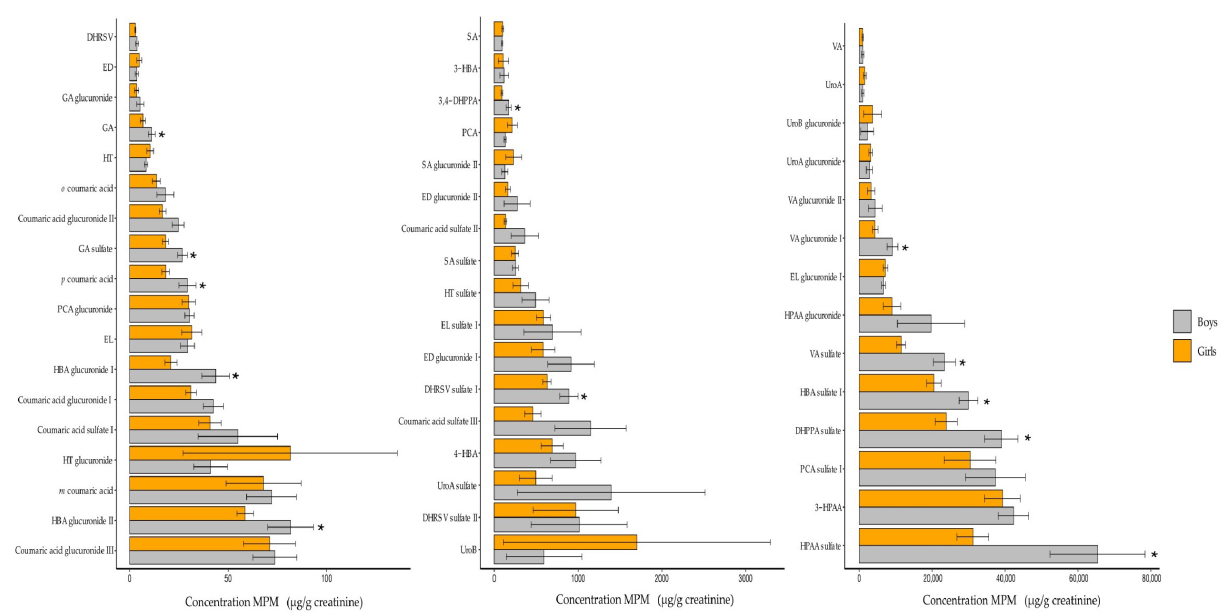
Figure 1. Urinary MPM of adolescents by gender. 3,4-DHPPA 3,4-dihydroxyphenylpropionic acid, 3-HPAA 3-hydroxyphenylacetic acid, 3-HBA 3-hydroxybenzoic acid, 3-HT 3-hydroxytyrosol, 3-HT-G 3-hydroxytyrosol glucuronide, 4-HBA 4-hydroxybenzoic acid, DHRSV dihydroresveratrol, ED en- terodiol, EL enterolactone, GA gallic acid, PCA protocatechuic acid, SA syringic acid, Uro-A urolithin A, uro-B urilithin B, VA vanillic acid. Bar graphs are plotted as the mean (SEM). * p -values < 0.05 from t -test